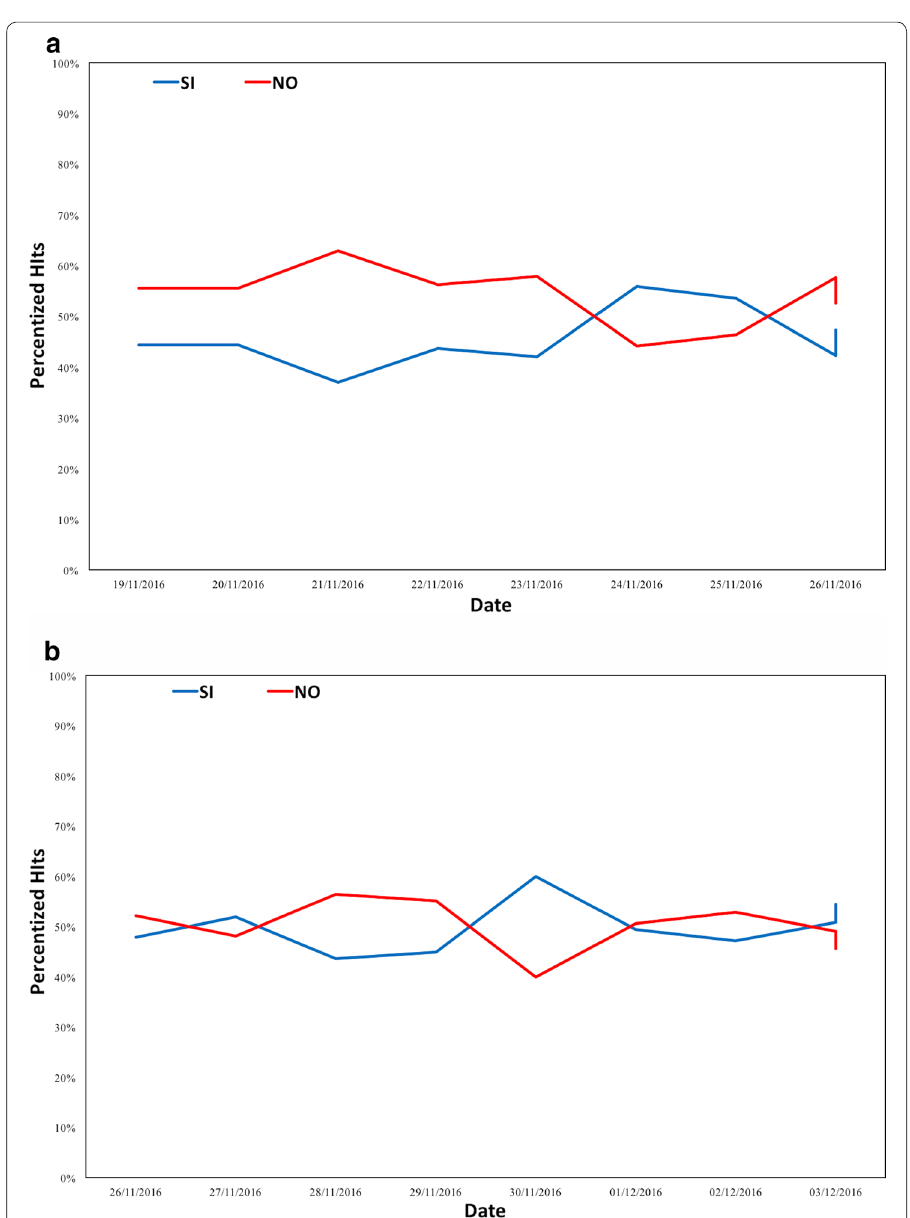
Fig. 7 Hourly percentized hits for YES and NO for ( a ) November 19th to 26th and ( b ) November 26th to December